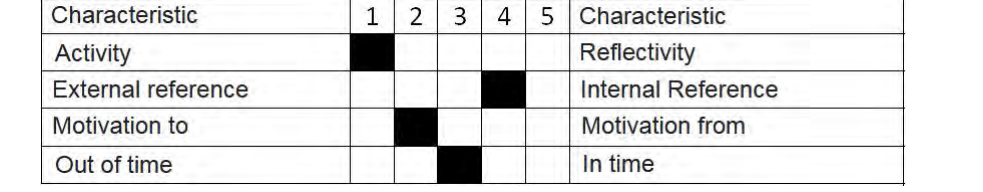
Fig. 1  A pattern of card of